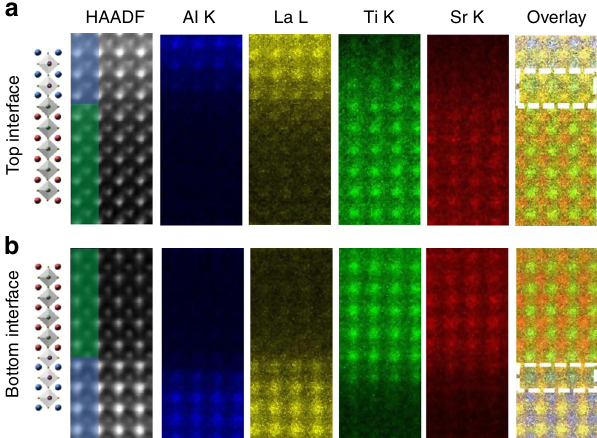
Fig. 2 Atomic structural characterization of the two interfaces in the LAO// STO/LAO heterostructure. a , b show the energy-dispersive X-ray spectroscopic (EDS) mappings of the top and bottom interfaces, respectively. From left to right: schematic structures, high-angle annular dark- fi eld image, Al K, La L, Ti K, and Sr K EDS integrated signal maps, and the combined elemental maps of all cations